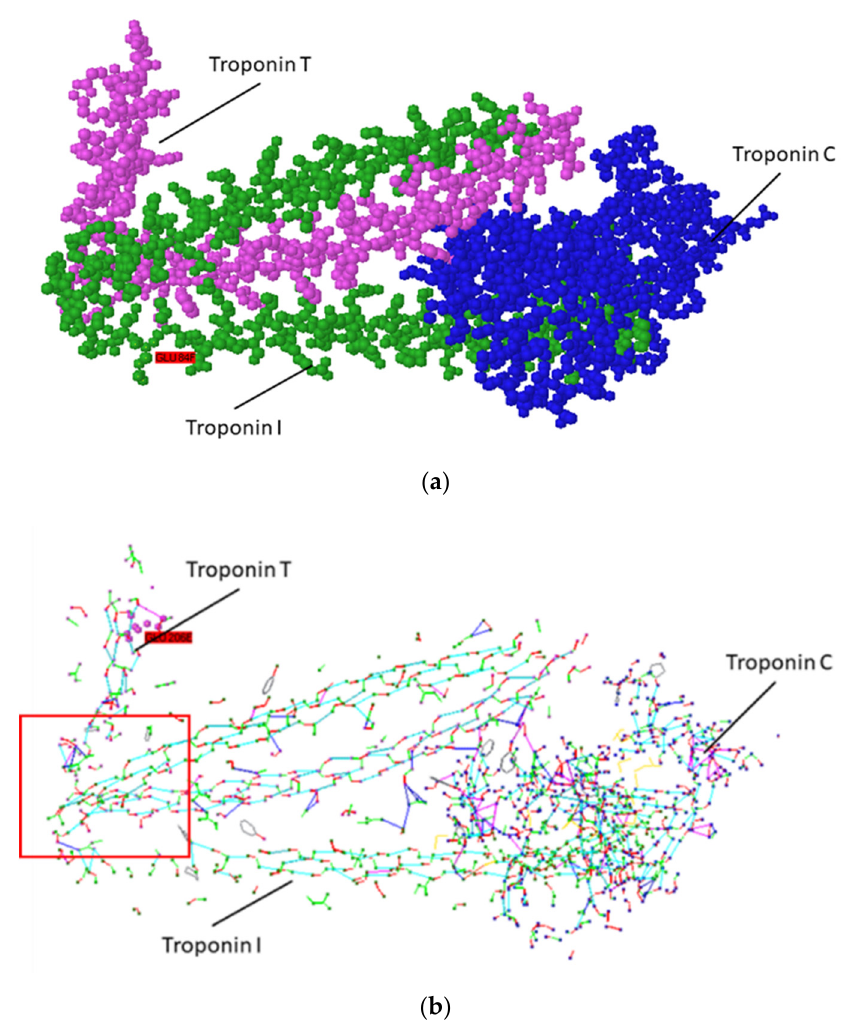
Figure 1. Structure of the troponin complex ( a ); troponin complex presented in the form of CIHBS rendering ( b ). Frame shows the area of contact between troponin T and troponin I, which is perspective for aptamer modeling. Table 1. List of synthesized